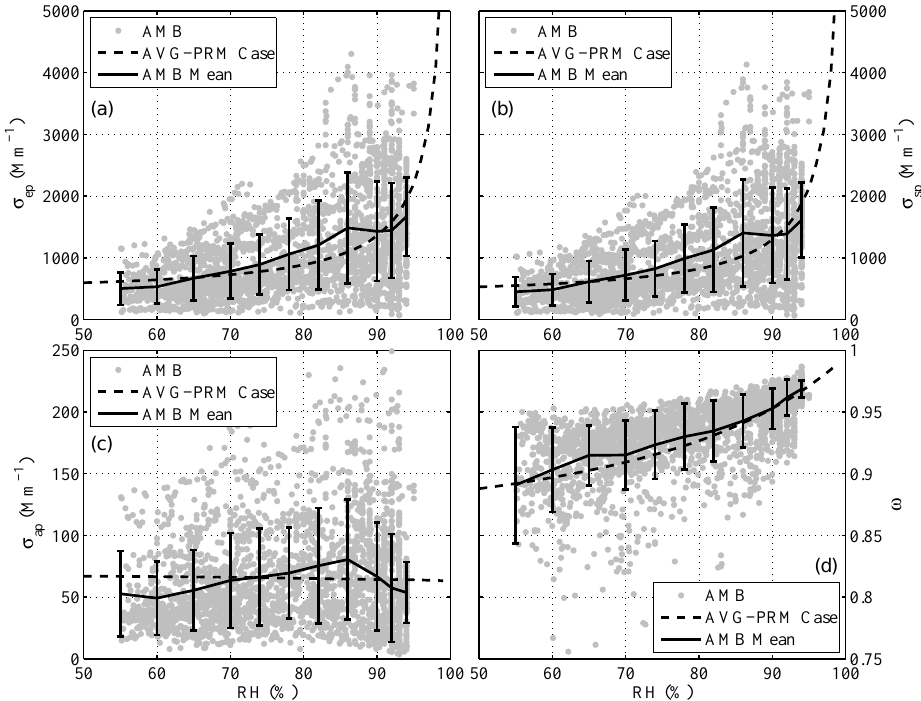
Figure 3. The dependence of σ ep (a) , σ sp (b) , σ ap (c) , and ω (d) at various RHs. The dots represent the ambient values of each measurement (AMB). The solid lines with bars represent the average and the deviation of the ambient values (AMB mean). The dashed lines represent the specific cases in which average input parameters are used (AVG-PRM